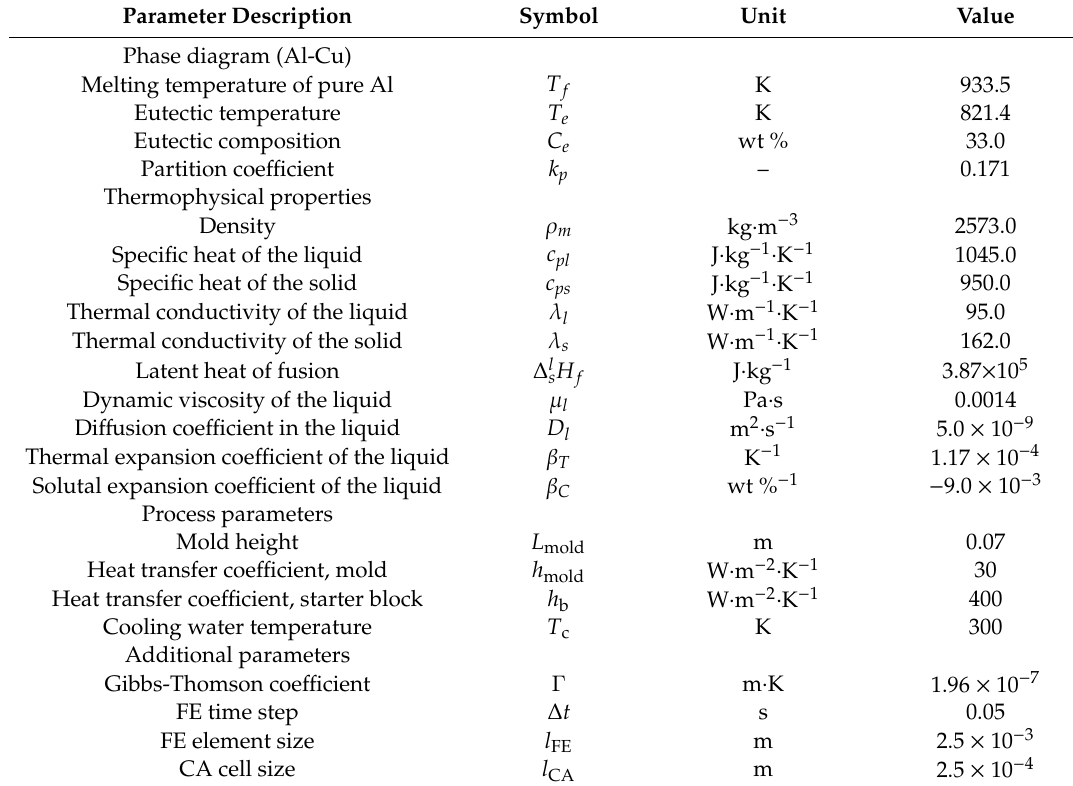
Table 1. Simulation parameters for Al-6.0 wt % Cu alloy [21].